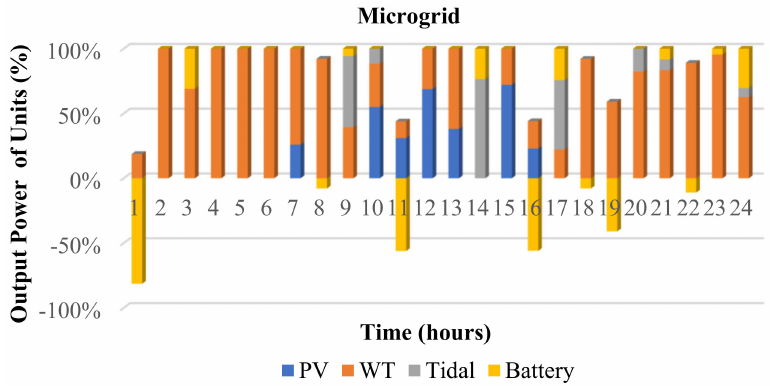
Figure 8. The generation power of each